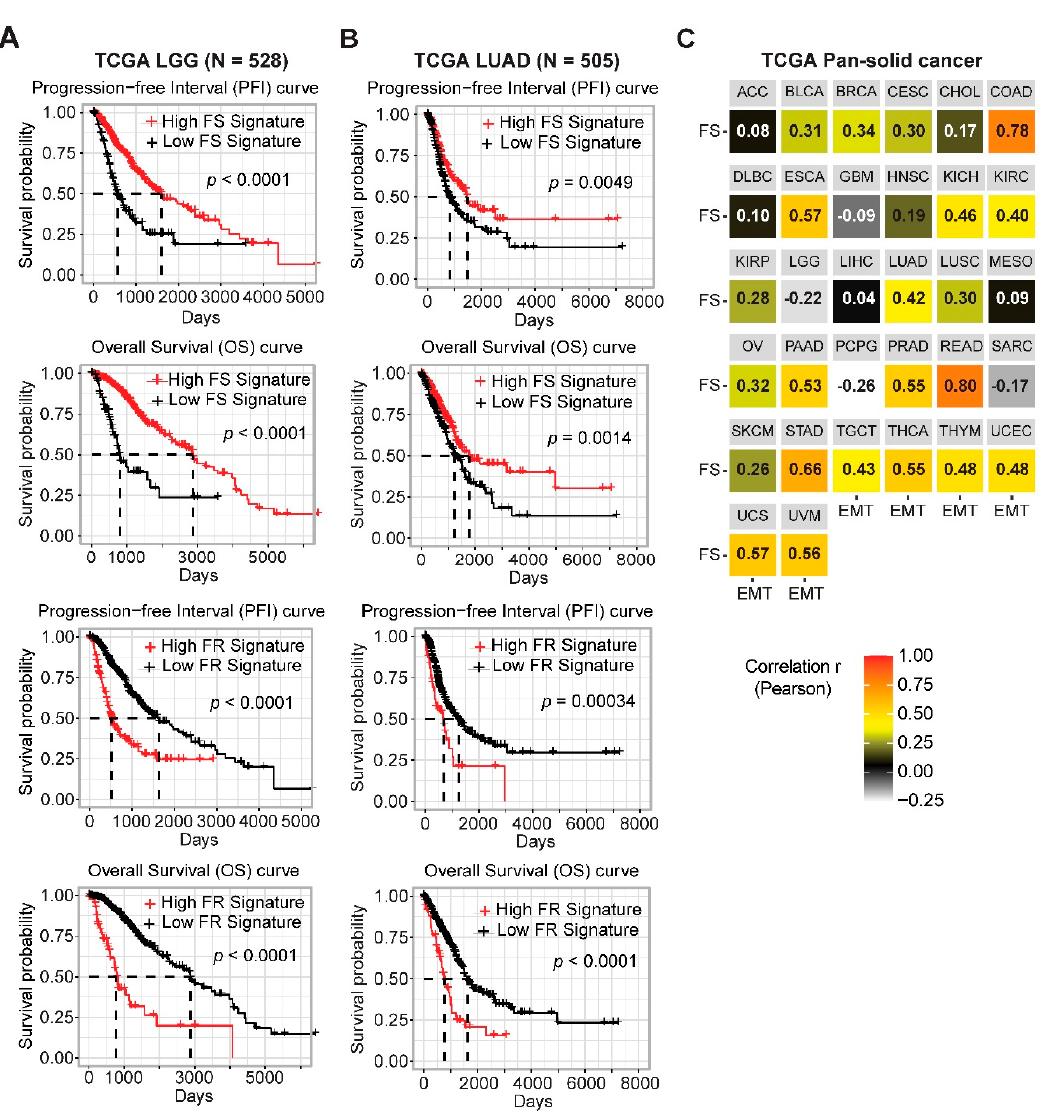
Figure 5. Prognostic values of the ferroptosis gene signature in cancer patients. ( A , B ), Kaplan–Meier survival analyses of LGG ( A ) and LUAD ( B ) stratified by the FS and FR gene signatures. ( C ), Correlation analysis of the epithelial-to-mesenchymal transition (EMT) and FS gene signatures grouped by cancer types across TCGA pan-cancer cohort.